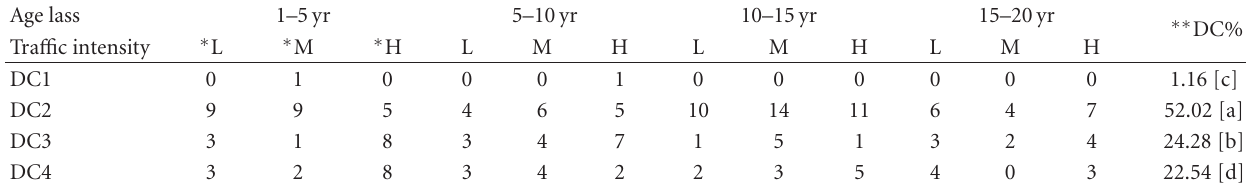
Table 7: Distribution of damaged trees based on size of wound.